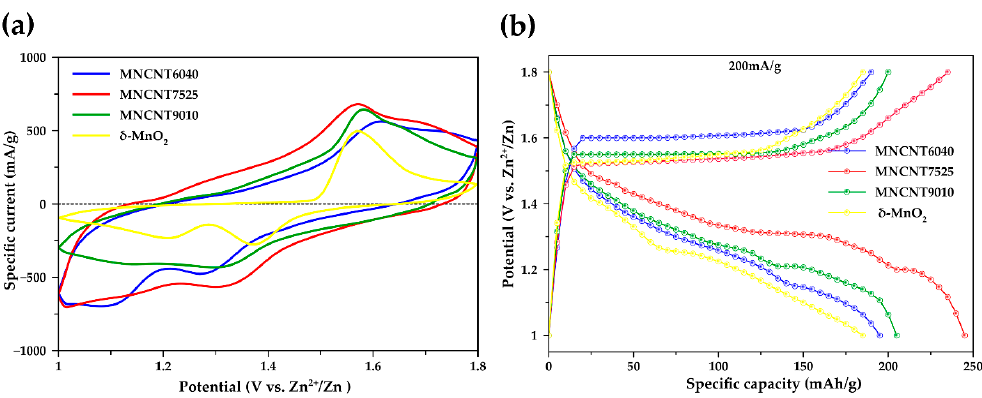
Figure 4. Electrochemical properties: ( a ) Cyclic voltammograms at a scan rate of 0.5 mV s − 1 ; ( b ) Galvanostatic charge–discharge profile at 200 mA g − 1 of the MN-CNT and δ -MnO 2 cathode.